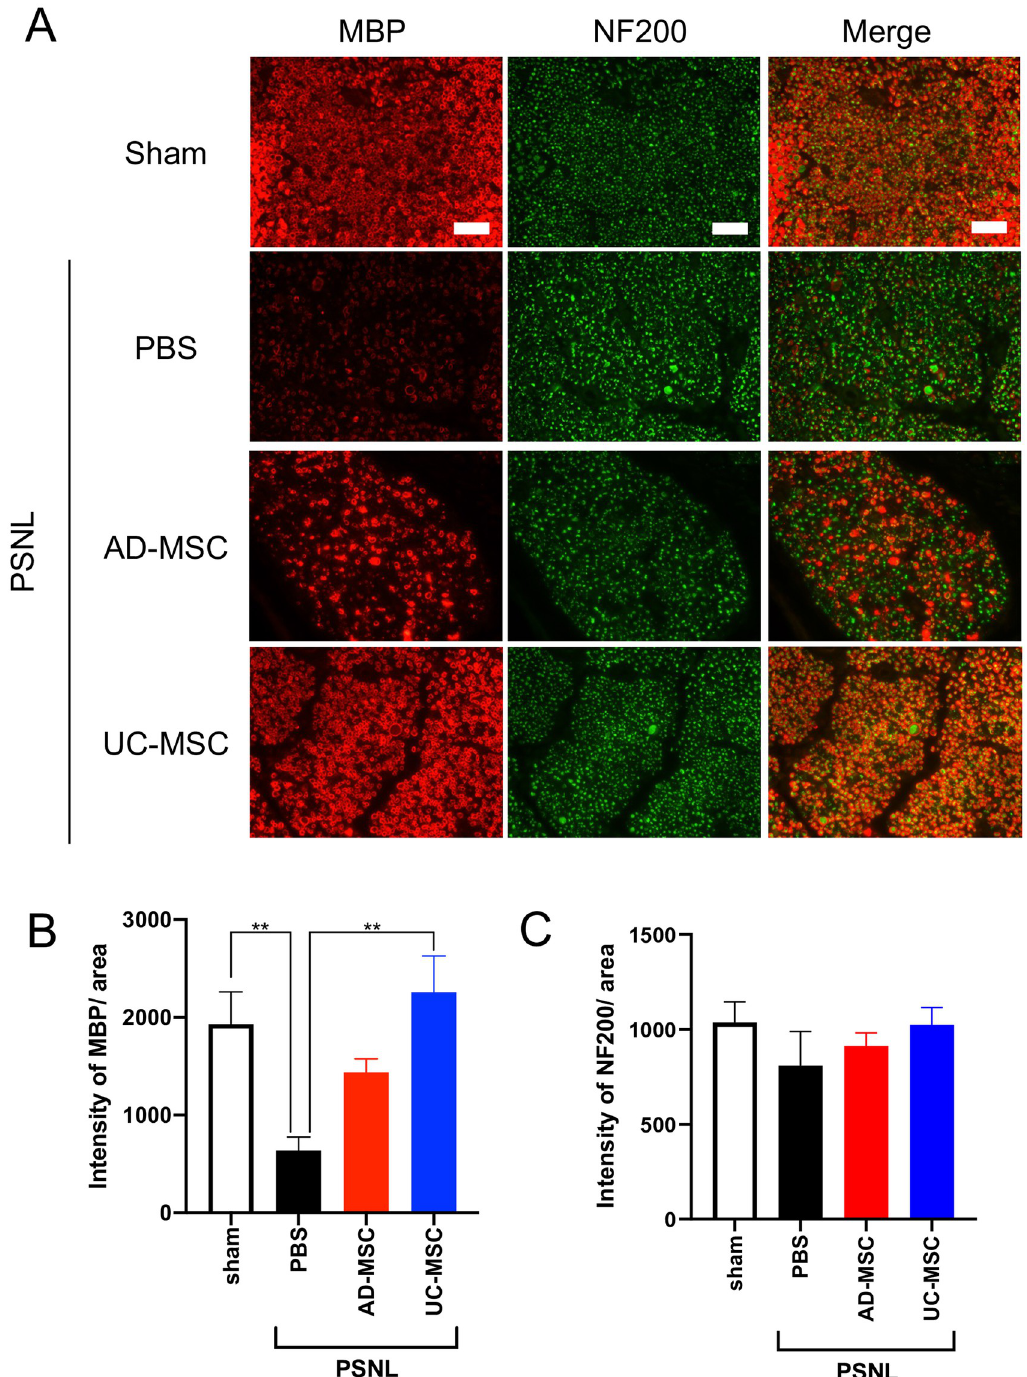
Fig 4. Changes in expression of myelin basic protein (MBP) and neurofilament heavy polypeptide (NF200) in the sciatic nerves of PSNL-exposed rats and the effects of treatment with MSCs. On day 4 after partial sciatic nerve ligation (PSNL), AD-MSCs, UC-MSCs (5 × 10 6 cells/mL), or its vehicle (PBS) was administered intravenously. On day 3 after injections, sciatic nerves were dissected from rats. The protein expression of MBP and NF200 in the sciatic nerves was measured by immunohistochemical analysis (A). The data are expressed as mean ± standard error of the mean (B and C, sham; n = 4, PBS; n = 5, AD-MSC; n = 6, UC-MSC; n = 6). �� indicates p < 0.01: Bonferroni’s multiple comparison test was performed following a one-way analysis of variance. Scale bar = 50 μ